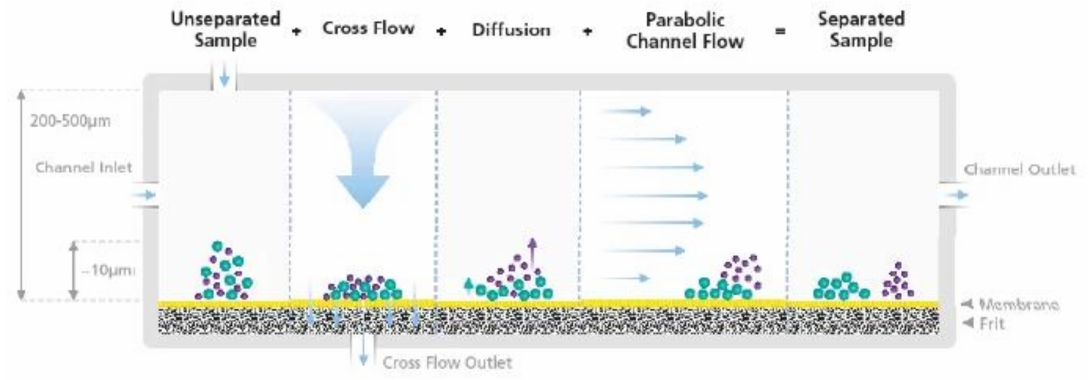
Figure 13. Operating principle of the AFFFF technique. Adapted with permission from [107]; published by LCGC,